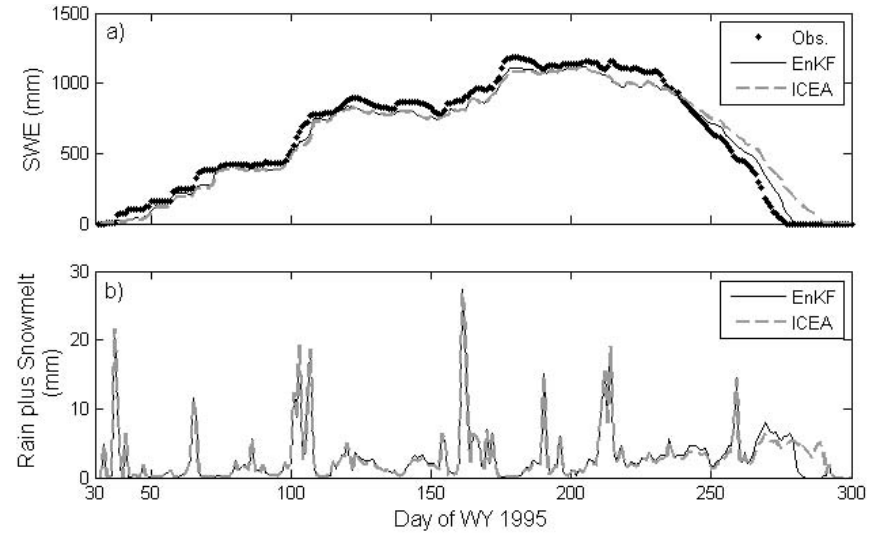
Fig. 10. Ensemble mean SWE (a) and Rain plus Snowmelt (b) time series for WY1995 derived from the stand-alone EnKF (black line) and the ICEA (dash line). Also shown in the upper panel is the areal SWE (circles) derived from SWE observations at three snow